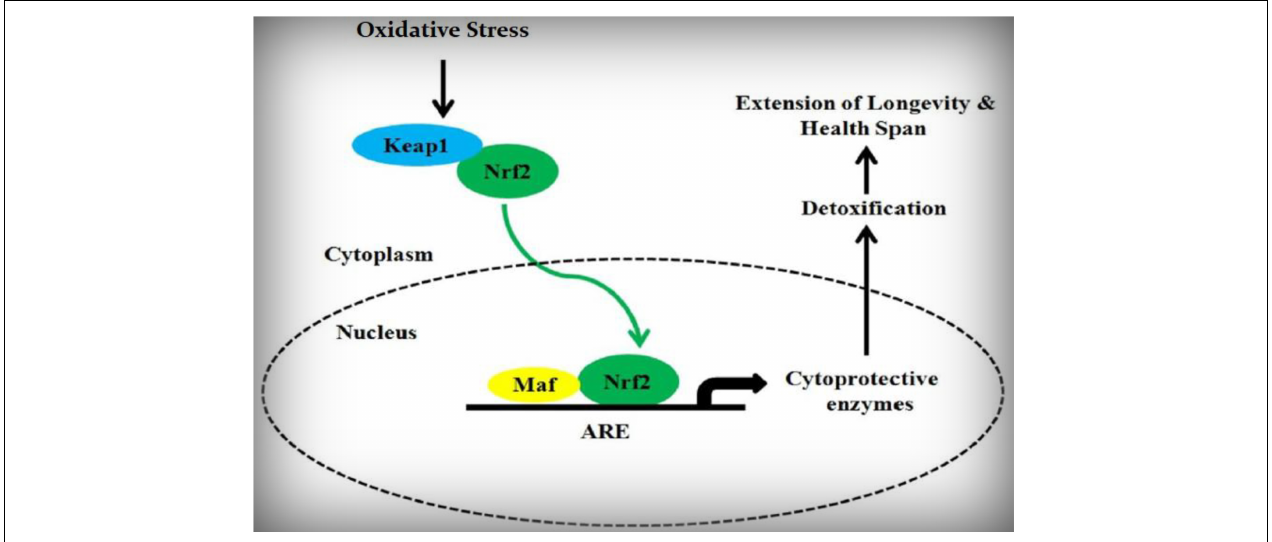
FIGURE 3 | Nrf2 schematic